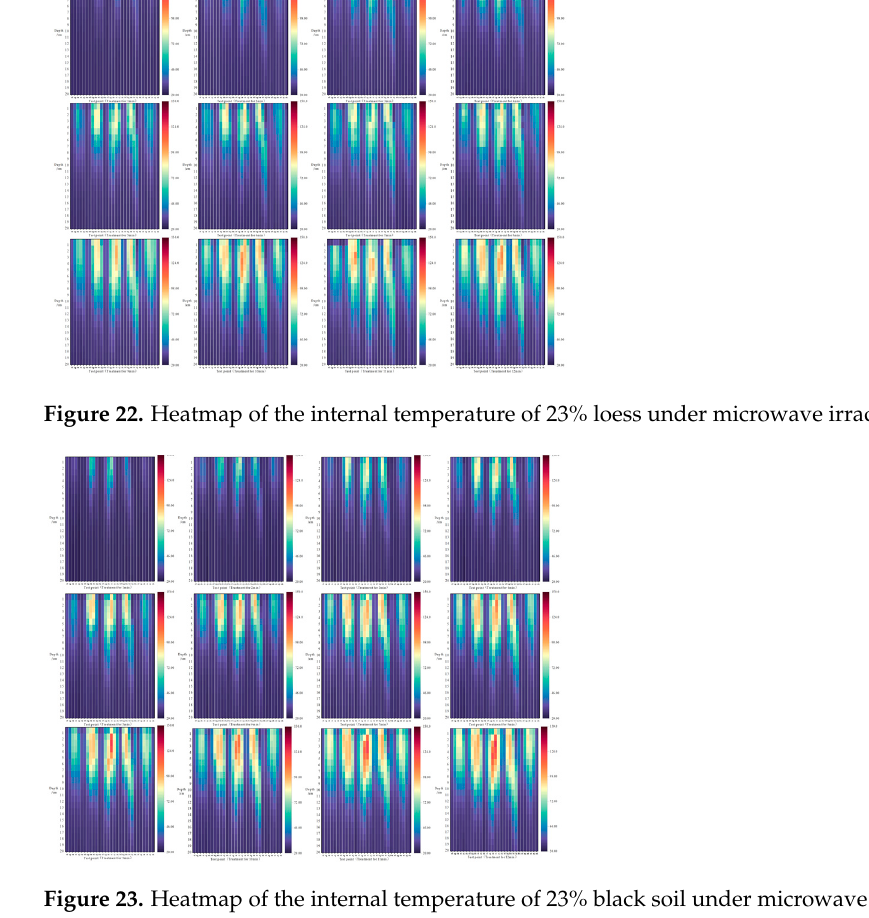
Figure 23. Heatmap of the internal temperature of 23% black soil under microwave irradiation.